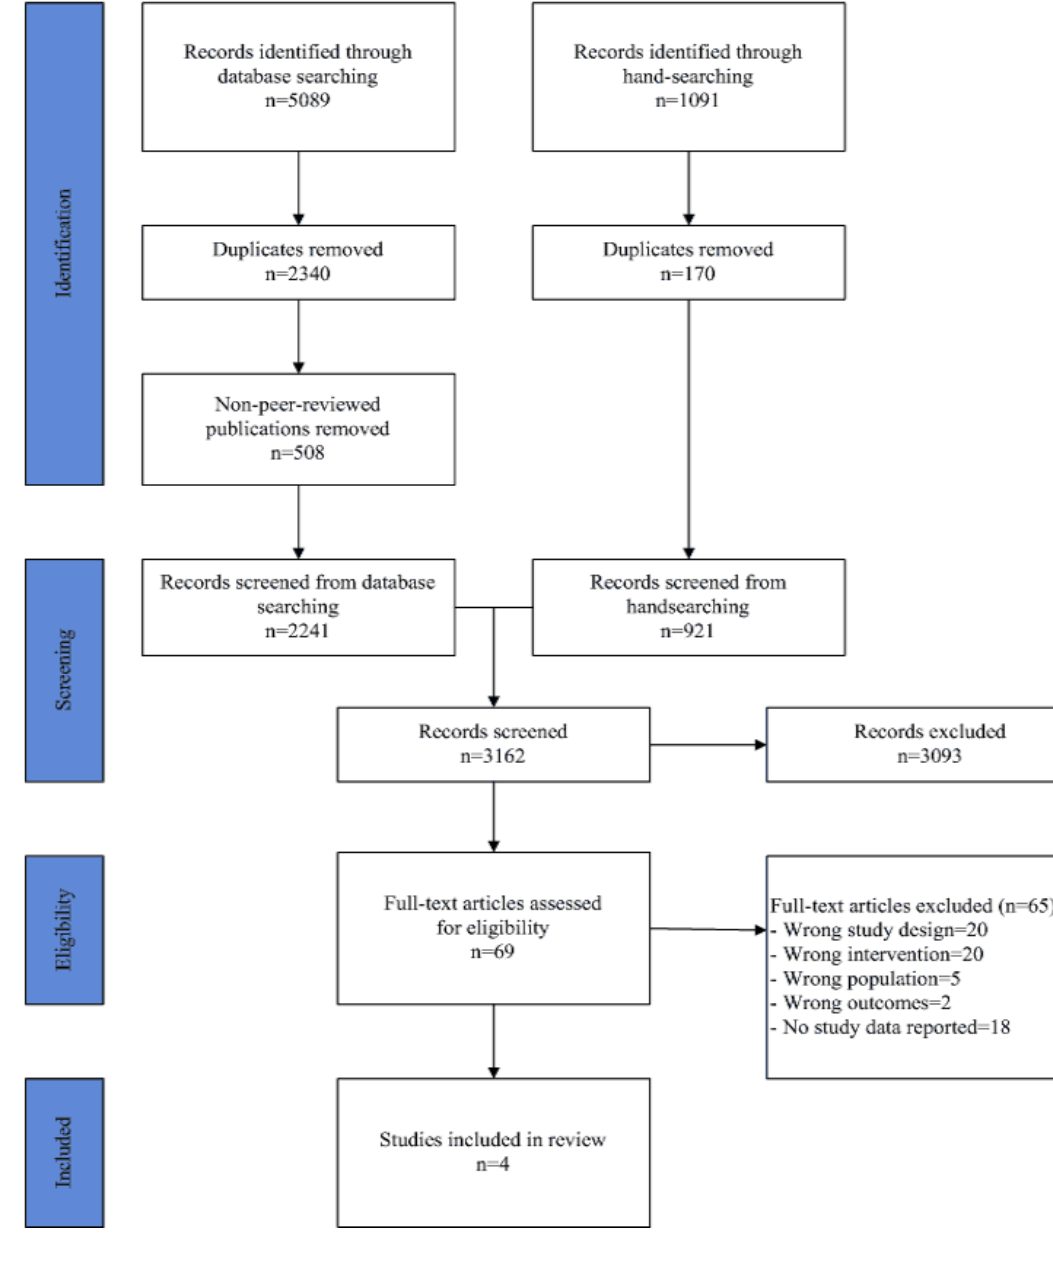
Figure 1. Preferred Reporting Items for Systematic Reviews and Meta-Analysis diagram of included and excluded